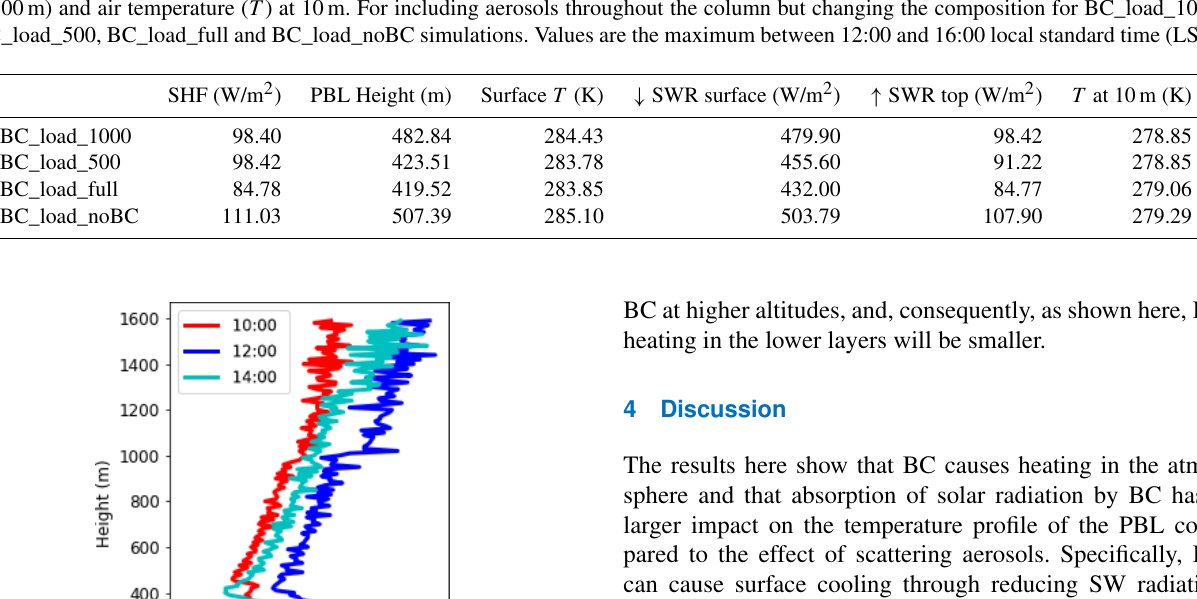
Table 7. Maximum sensible heat flux (SHF), planetary boundary layer (PBL) height (taken as the height with the largest gradient in θ ), surface temperature ( T ), downwelling shortwave radiation ( ↓ SWR) at the surface, upwelling shortwave radiation ( ↑ SWR) at model top (1800m) and air temperature ( T ) at 10m. For including aerosols throughout the column but changing the composition for BC_load_1000,